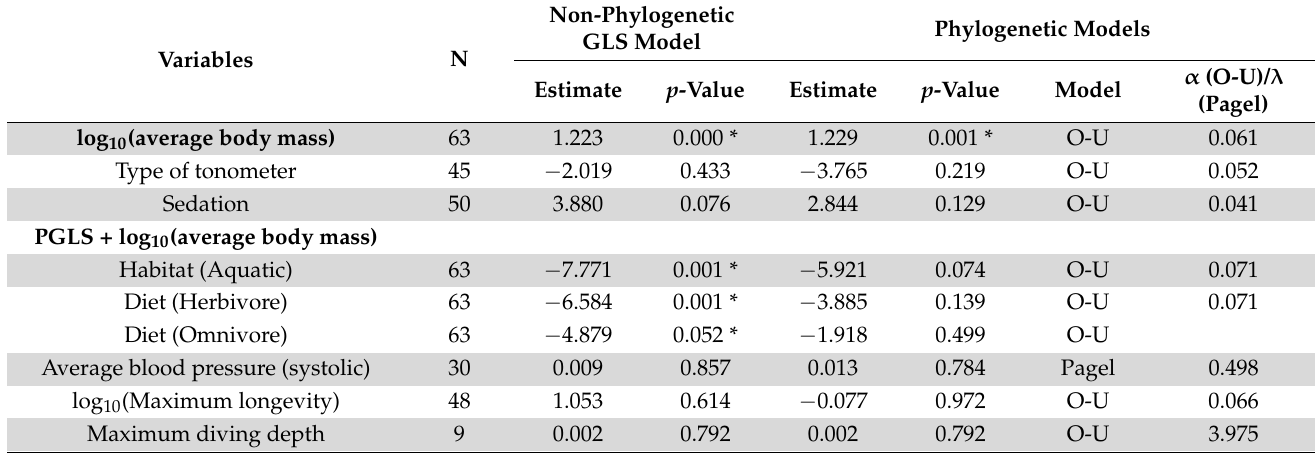
Table 2. Results of generalized least squares, with and without phylogenetic models, for life history traits in mammals. Asterisks represent significant results. For the habitat variable, terrestrial is the reference level. For the diet variable, carnivore is the reference level.